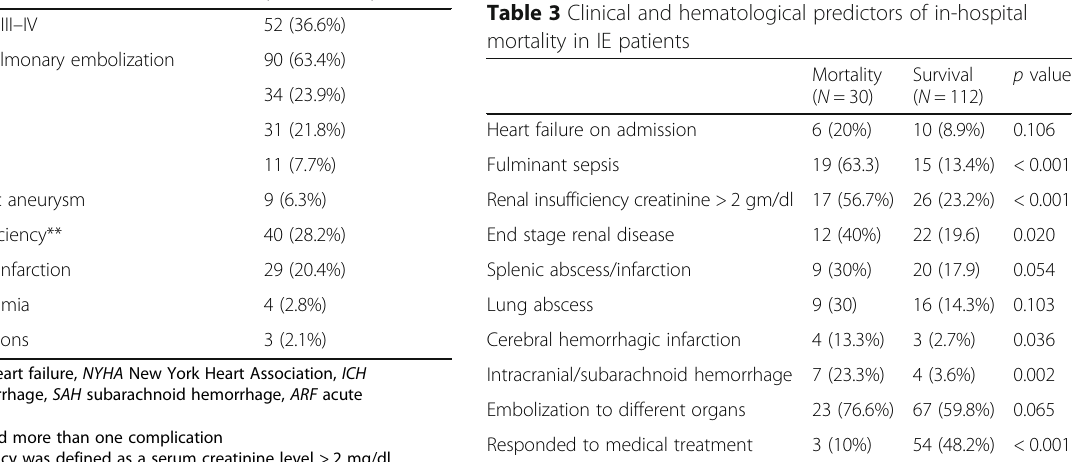
Table 3 Clinical and hematological predictors of